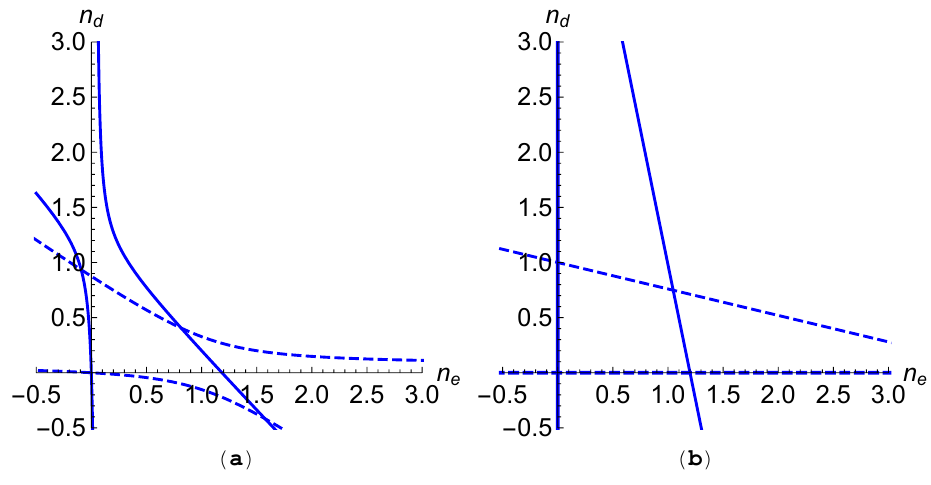
Figure 3. ( a ) Nullclines of Equation (6) and ( b ) Nullclines of Equation (17). Parameter values D e = 0.3, D d = 1.5, r e = 1.1, r d = 0.2, m ee = 1.0/1.2, m dd = 1.0, m ed = 0.8, m de = 0.7, µ e = 0.01, µ d =